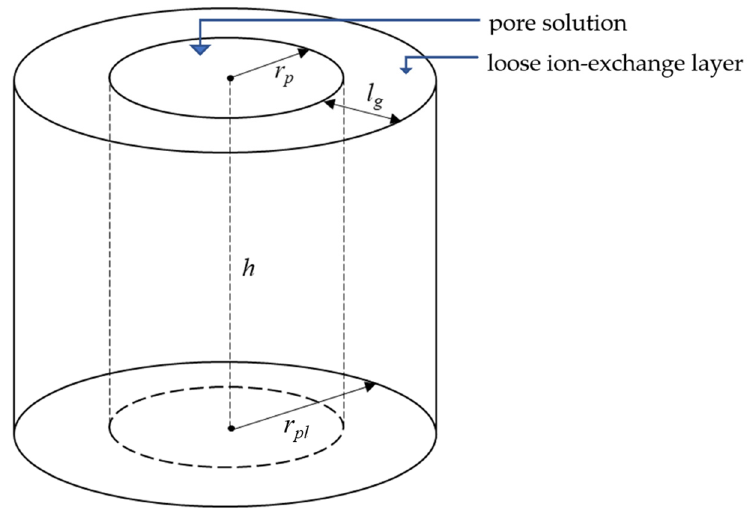
Figure 1. Schematic representation of a system that includes a solution in a TEM pore with a radius r p and a loose (gel) layer with a thickness of l g . r p and a loose (gel) layer with a thickness of l g